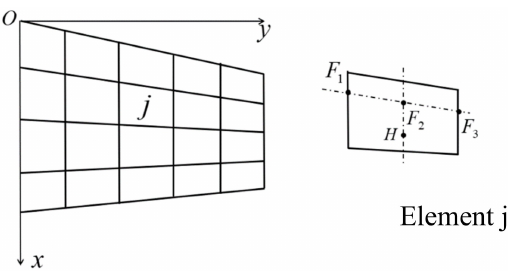
Figure 3. Schematic diagram of lifting surface grid in the doublet lattice method